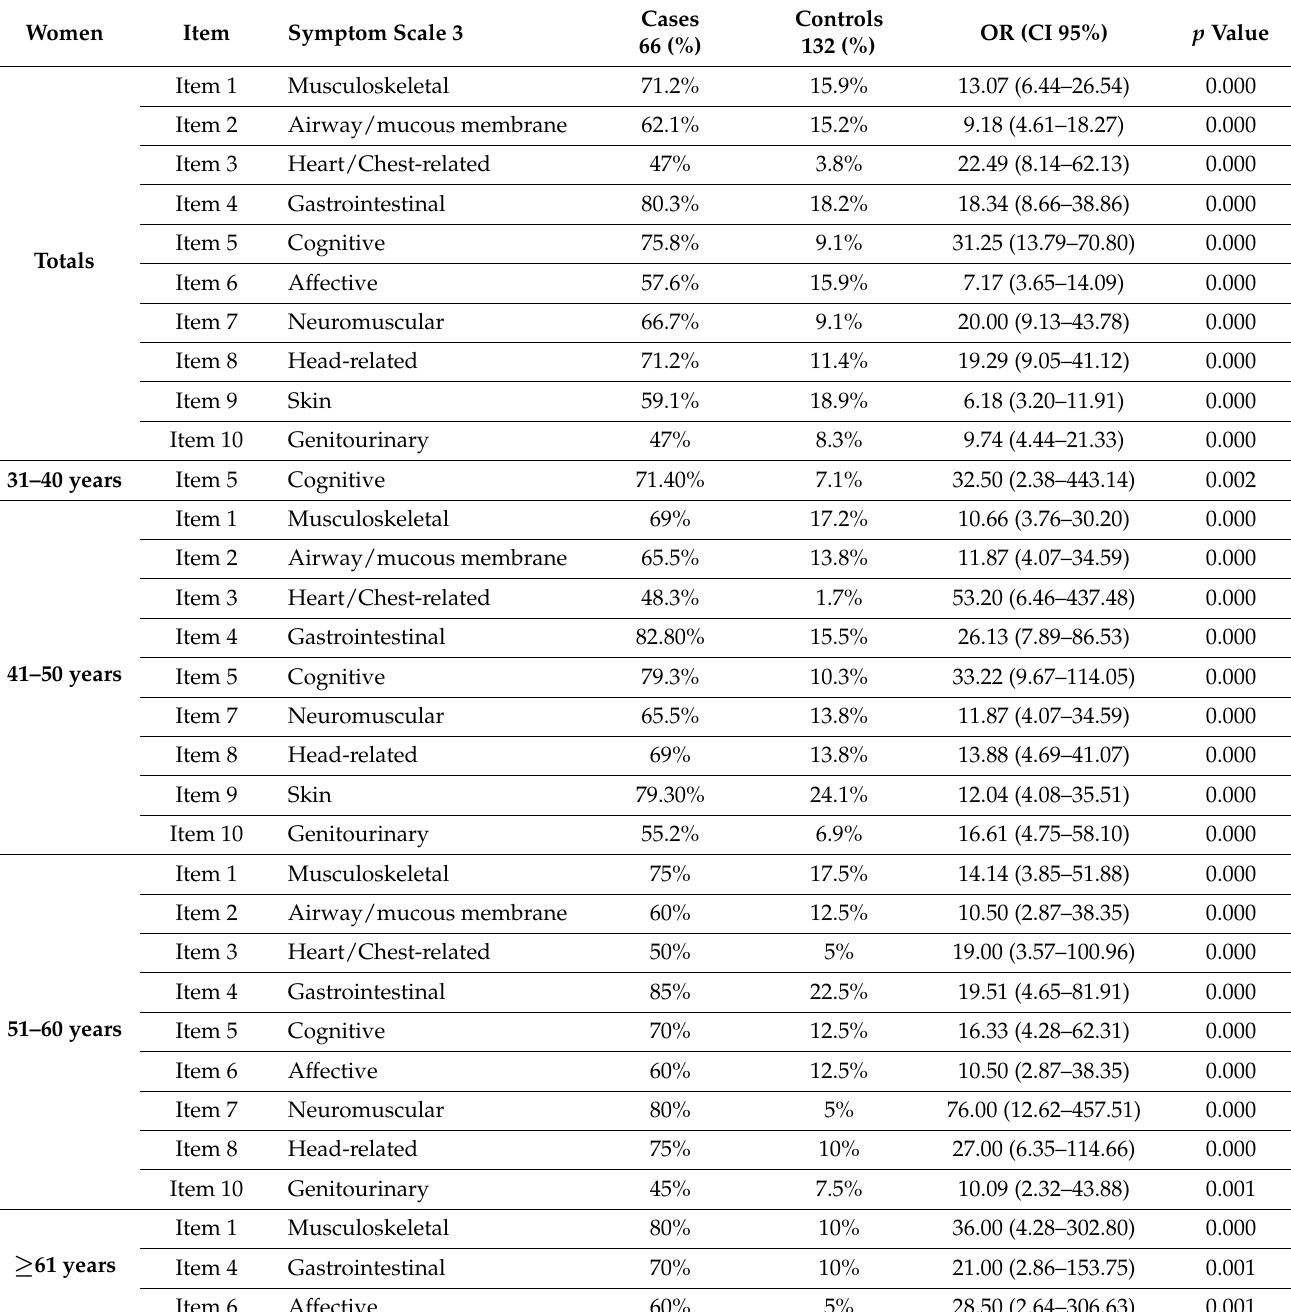
Table 6. Odds Ratio and 95% CI of the symptoms in which association with MCS disease has been found in groups of women by age